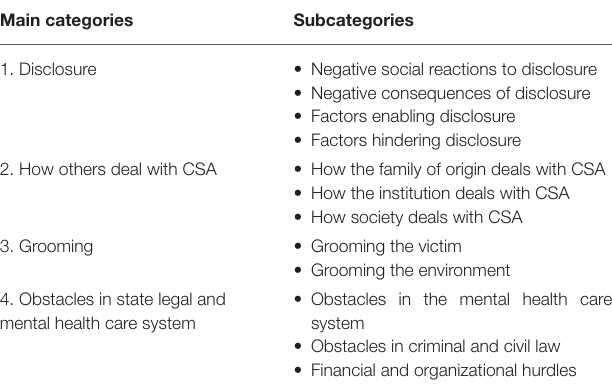
TABLE 2 | Main- and subcategories of contextual obstacles in dealing with